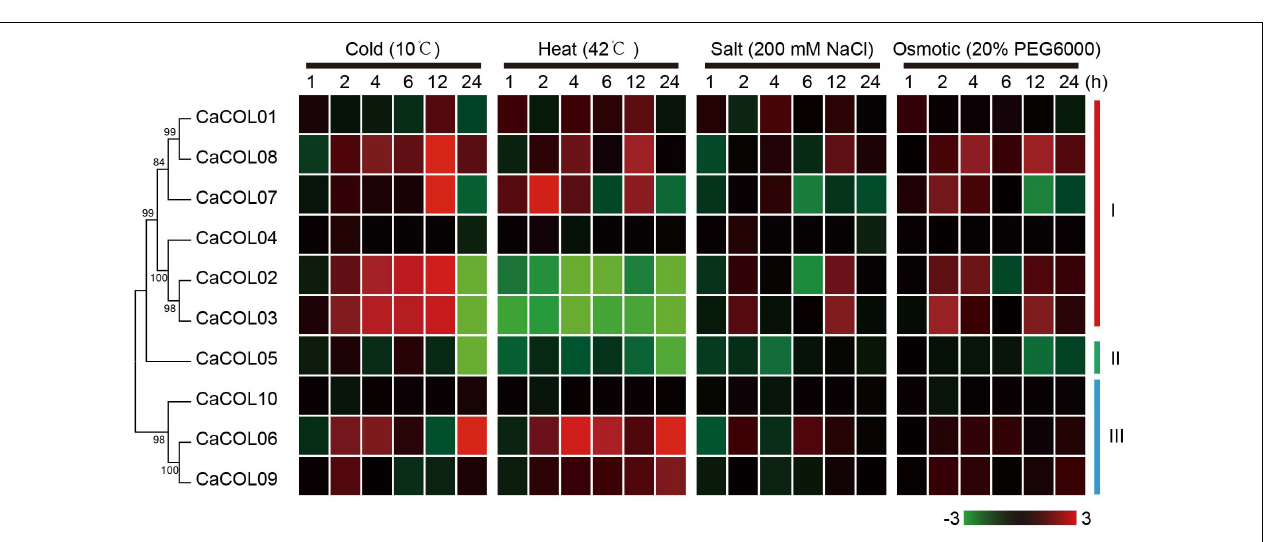
FIGURE 8 | Effect of light on the expression patterns of COLs in pepper leaves. Line charts indicate transcript levels of COL genes. For each sample, transcript levels were normalized with those of actin (control). Data are the mean values ± standard deviation (SD) of three individual experiments ( n = 3).